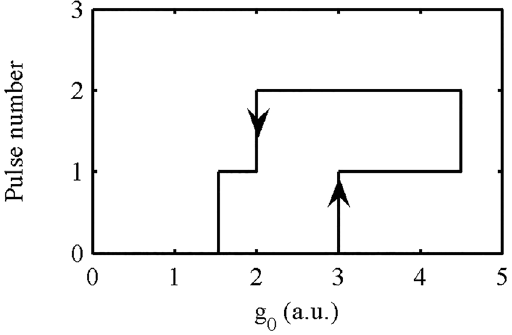
Figure 7. Hysteresis and multistability for pulse number in the mode-locked